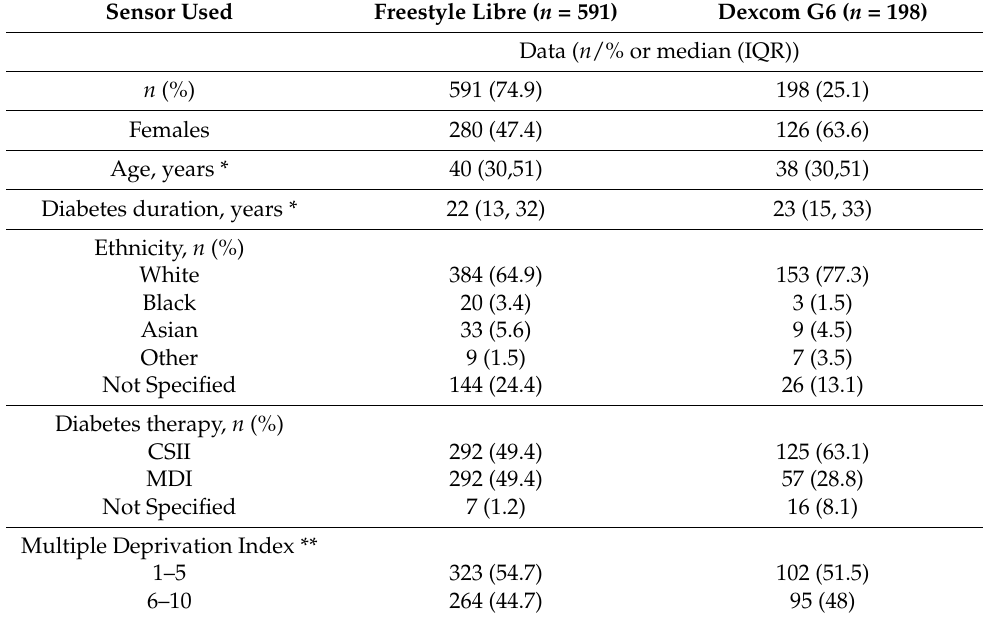
Table 1. Baseline